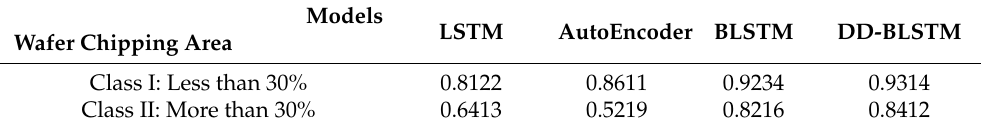
Table 4. The accuracy of prediction models using Barnes-Hut t-SNE.